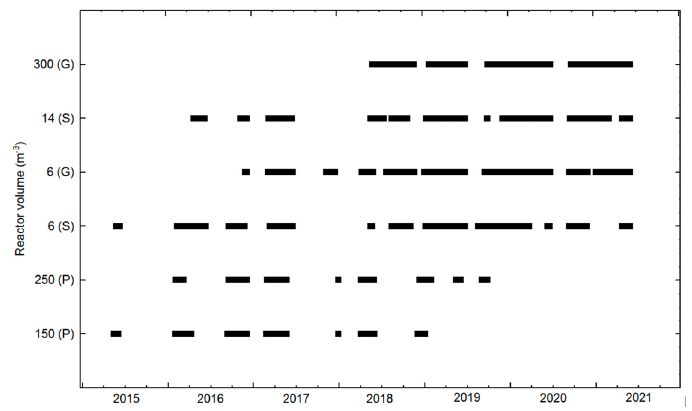
Figure 1. Photobioreactor cultivation periods from May 2015 until July 2021 at Finnfjord AS. Letters in parentheses refer to type of reactor 150 (P) = 150 L Plexi, 250 (P) = 250 L Plexi, 6 (S) = 6000 L Steel, 6 (G) = 6000 L Glass fiber, 14 (S) = 14,000 L Steel, 300 (G) = 300,000 L glass fiber.